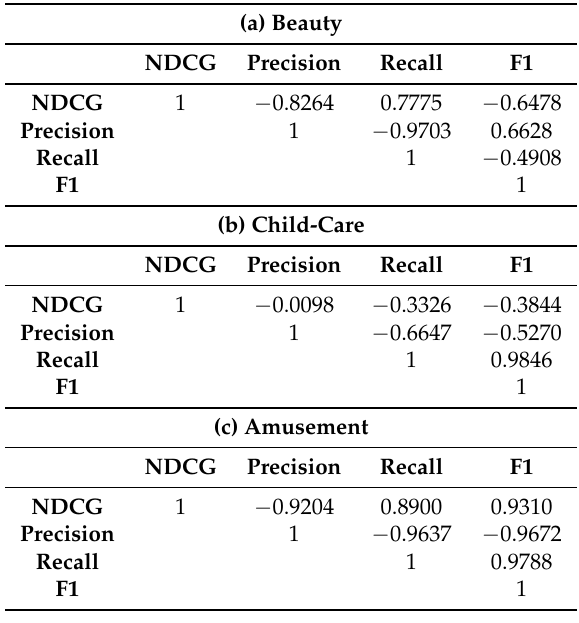
Table 9. Correlation among NDCG, precision, recall, and F1.